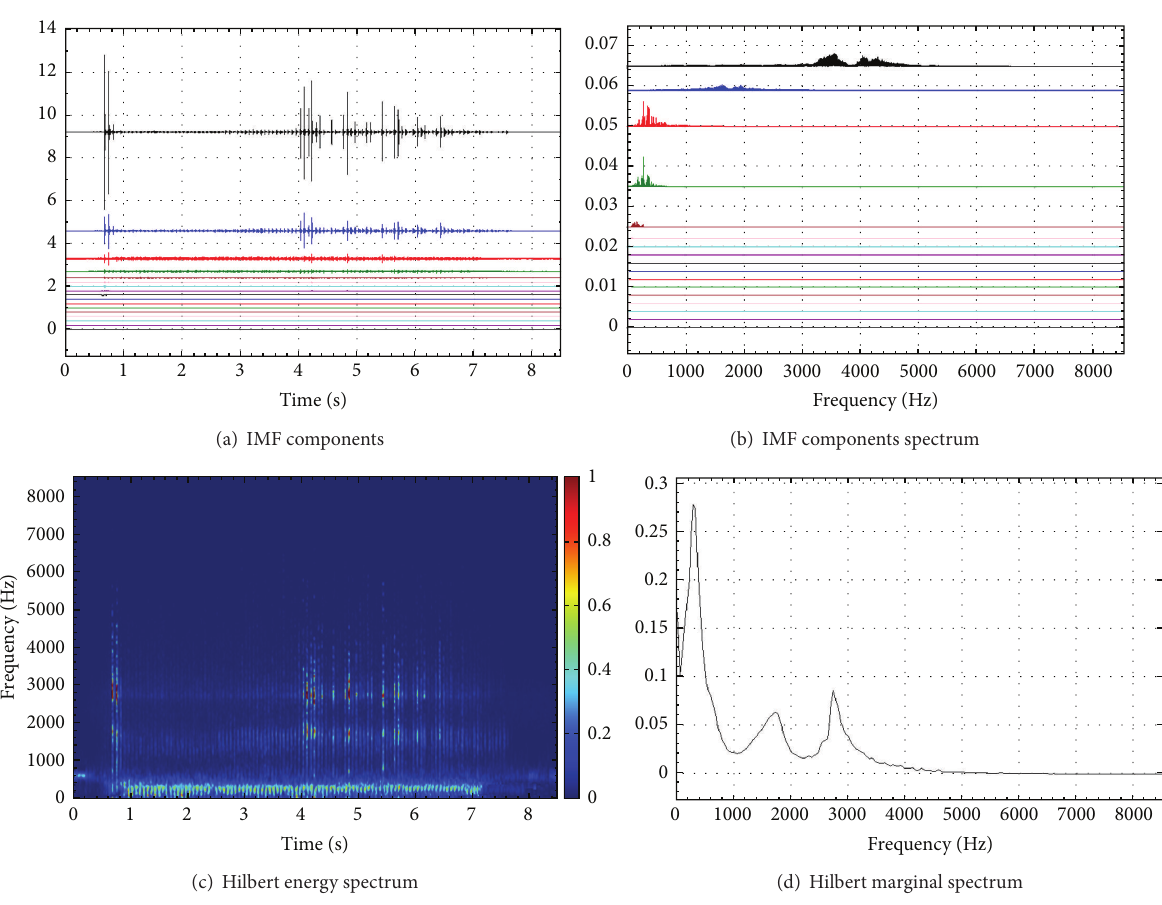
Figure 33: HHT analysis results in working condition